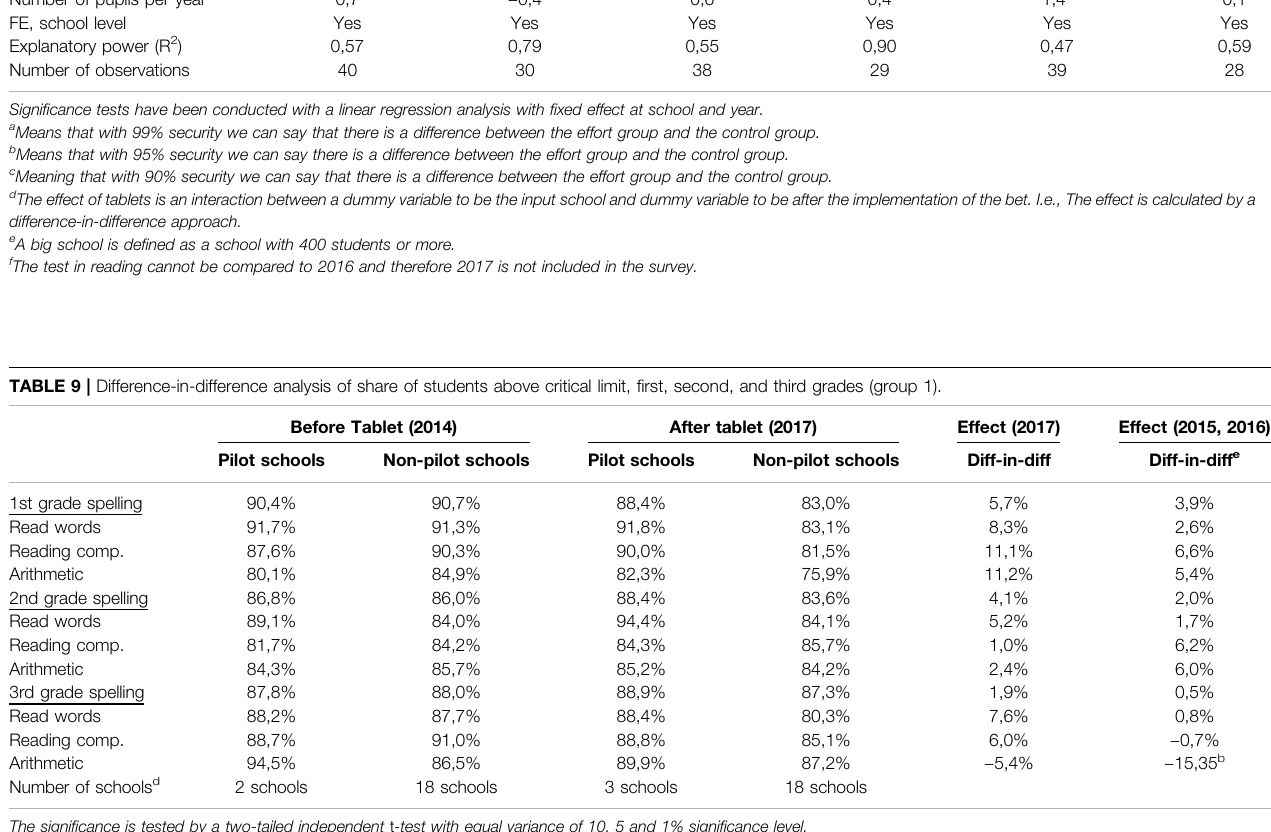
results in the difference-in-difference analysis from Table 3